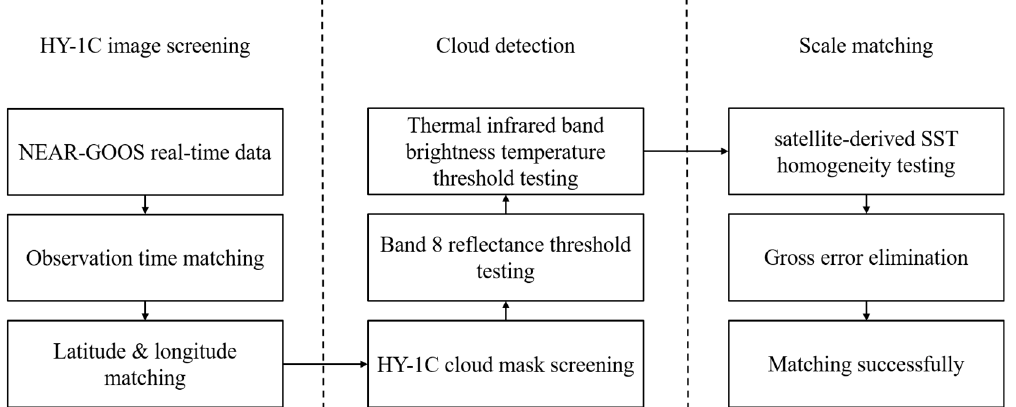
Figure 2. Data matching process between HY-1C satellite data and NEAR-GOOS real-time data.